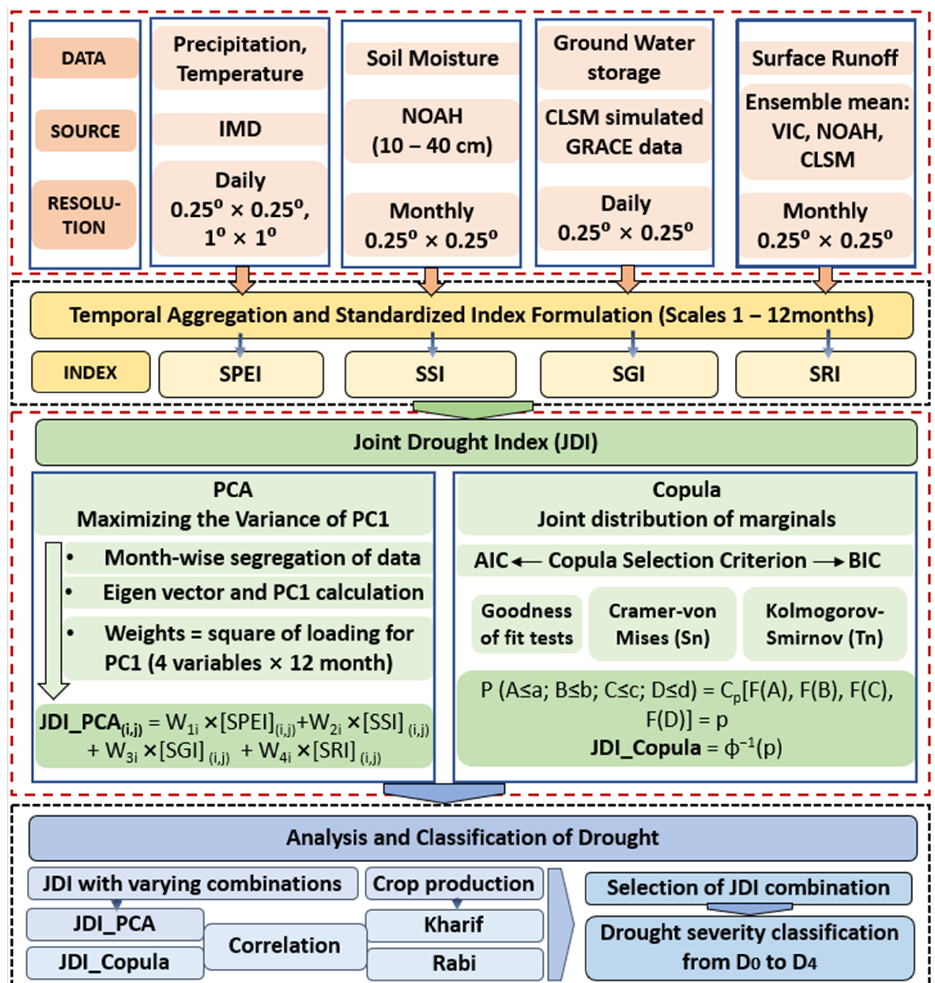
Figure 1. A schematic diagram depicting the methodology, various data sources, and the analyses conducted in this study. JDI_PCA and JDI_Copula represent the joint drought index derived from the PCA and Gaussian copula methods. Please refer to Section 2.1 for the abbreviation related to various data sources and the drought indices.